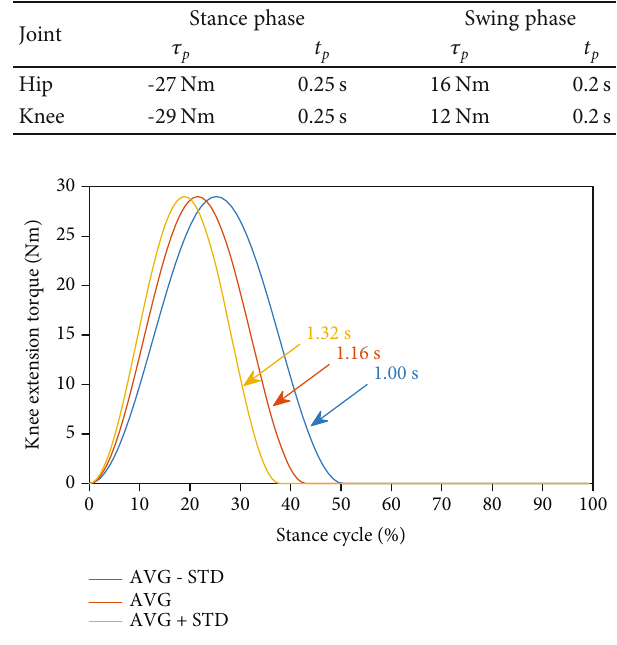
Figure 4: Example of knee extension torque for di ff erent stance times with the same t p (0.25 s). AVG and STD indicate the mean and standard deviation of the stance time of the subject,